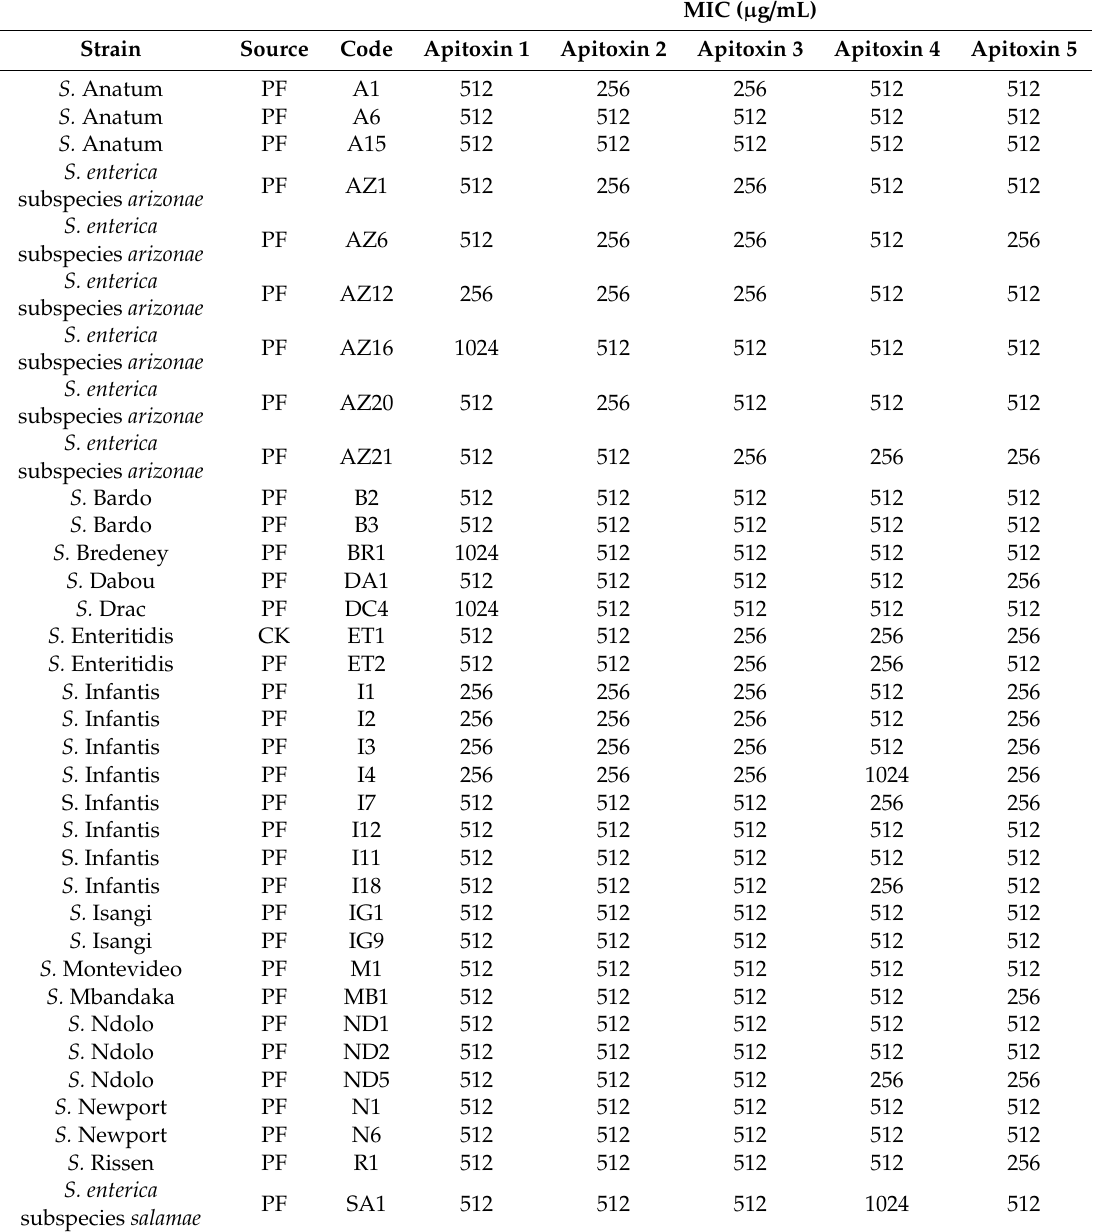
Table 1. Minimum inhibitory concentrations (MICs) of five apitoxins tested in 50 Salmonella strains isolated from